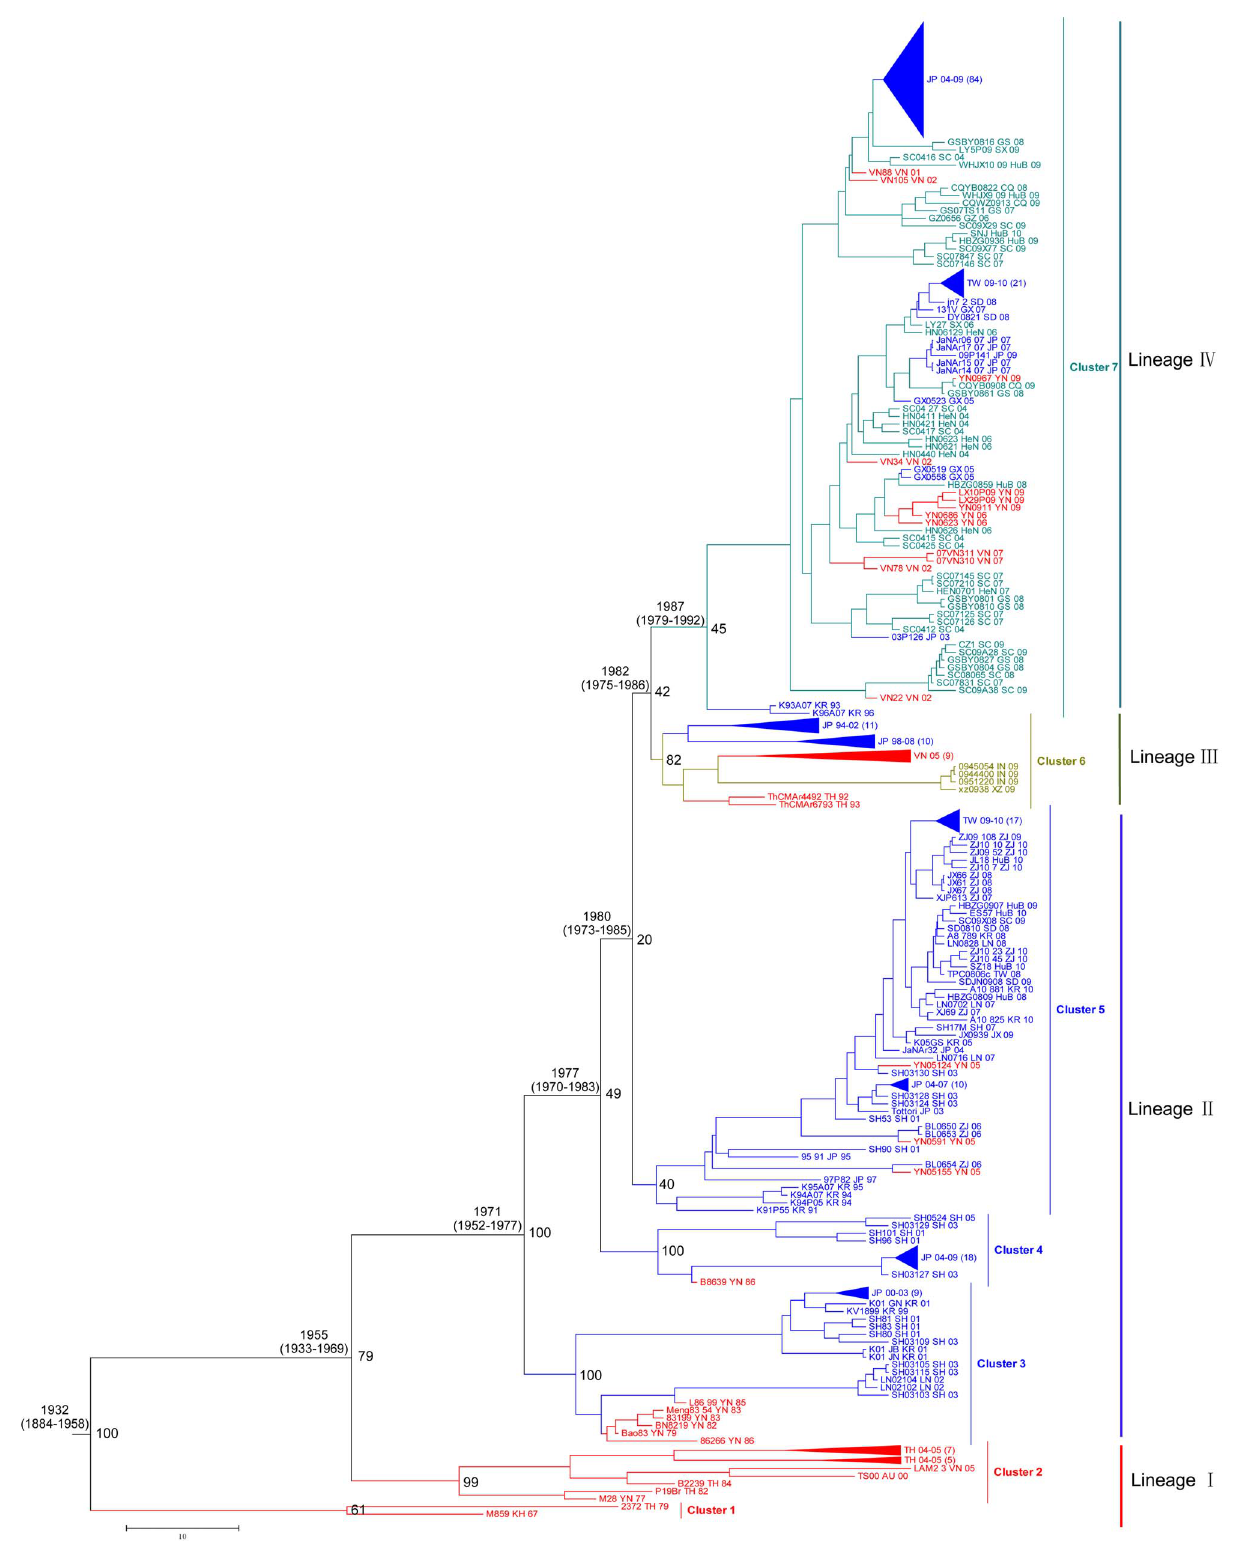
Figure 1. Maximum clade credibility tree for E gene sequences of genotype 1 JEV. Seven clusters were identified and estimated TMRCAs of these clusters (with their 95% HPD values in parentheses) are shown. Four endemic cycles were grouped based on the geographical locations of JEV strains in each cluster. Red, blue, olive and turquoise were used to mark strains from southernmost Asia, eastern coastal Asia, western Asia, and central Asia, respectively. Posterior probability values of each cluster and endemic cycles were showed in the right of the nodes. In order to present all available sequences in the tree, black triangles were used to condense strains with the same isolation place and similar isolation times. doi:10.1371/journal.pntd.0002459.g001 PLOS Neglected Tropical Diseases | www.plosntds.org